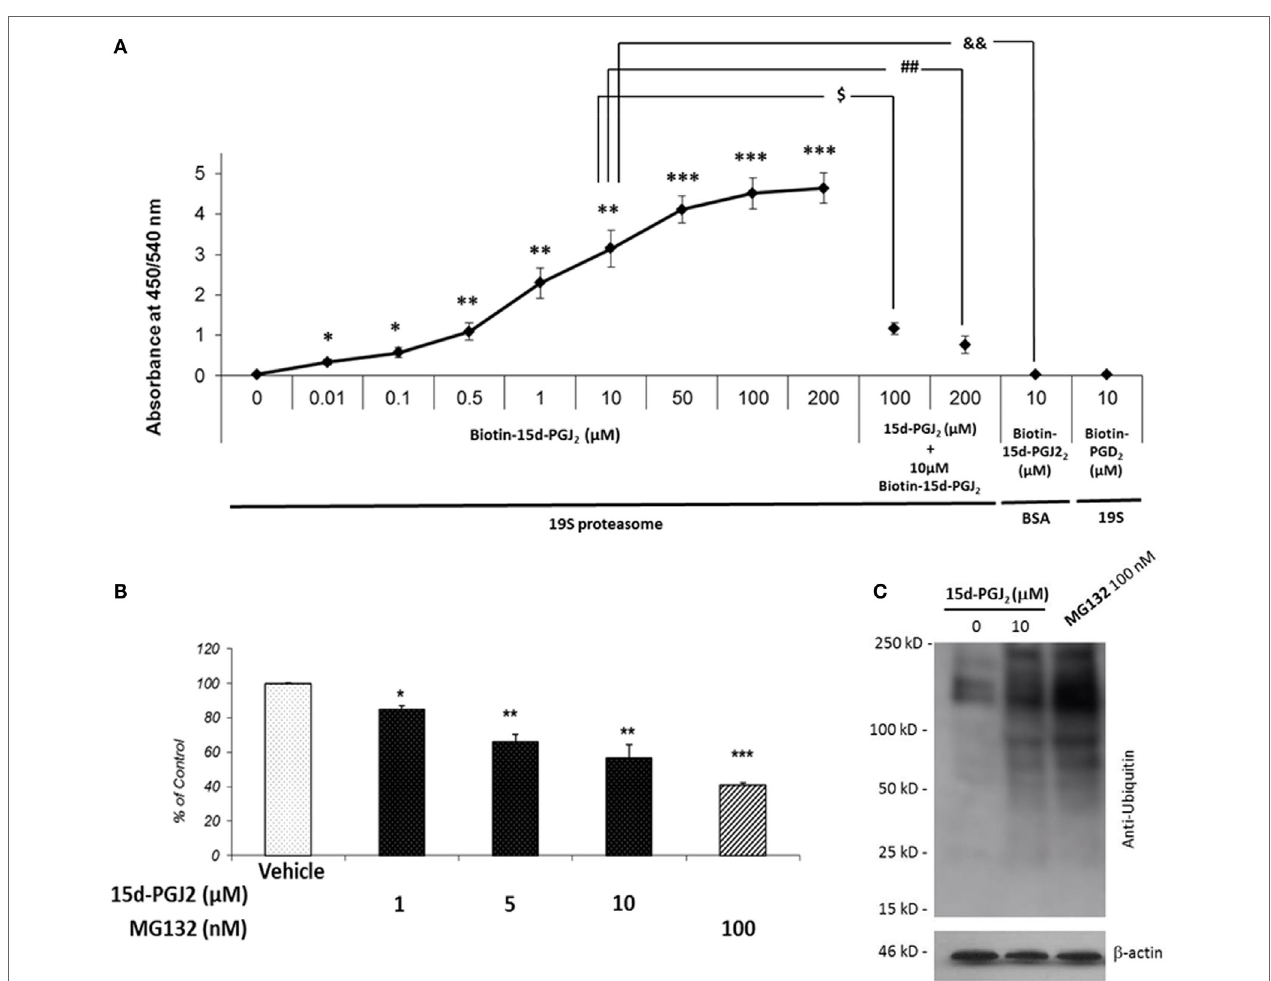
FigUre 2 | 15d-PgJ 2 covalently binds to 19s proteasome proteins, inhibits proteasome activity, and induces accumulation of proteins conjugated to ubiquitin . (a) The interaction of biotin-15d-PGJ 2 with purified 19S proteasome was assayed on a 19S-coated ELISA plate. The specificity of the interaction was confirmed in competition assays using 10- and 20-fold molar excess of unlabeled 15d-PGJ 2 , and by using biotin-PGD 2 . Data are expressed as mean ± SEM vs. control of three independent experiments. *** p < 0.001, ** p < 0.01, and * p < 0.05 biotin-15d-PGJ 2 vs. vehicle (0 μ M biotin-15d-PGJ 2 ). $ ( p < 0.05) 10-fold molar excess of unlabeled 15d-PGJ 2 vs. biotin-15d-PGJ 2 ; ## ( p < 0.01) 20-fold molar excess of unlabeled 15d-PGJ 2 vs. biotin-15d-PGJ 2 ; && ( p < 0.01) biotin-15d-PGJ 2 in the absence of 19S proteasome. (B) The peptidase activity of the proteasome in EC lysates treated with 15d-PGJ 2 for 18 h was measured using a fluorogenic substrate (SUC-LLVY-AMC). For comparison, the effect of the known proteasome inhibitor MG132 is shown. Inhibition of proteasome activity was expressed as fluorescence unit per wavelength and reported as percentage of control (ethanol) (mean ± SEM, n = 3); *** p < 0.001, ** p < 0.01, and * p < 0.05 15d-PGJ 2 or MG132 vs. vehicle. (c) Anti-ubiquitin Western blot analysis of EC treated with 10 μ M 15d-PGJ 2 or with 100-nM MG132 for 18 h resulted in accumulation of proteins conjugated to ubiquitin, consistent with a decreased proteasomal